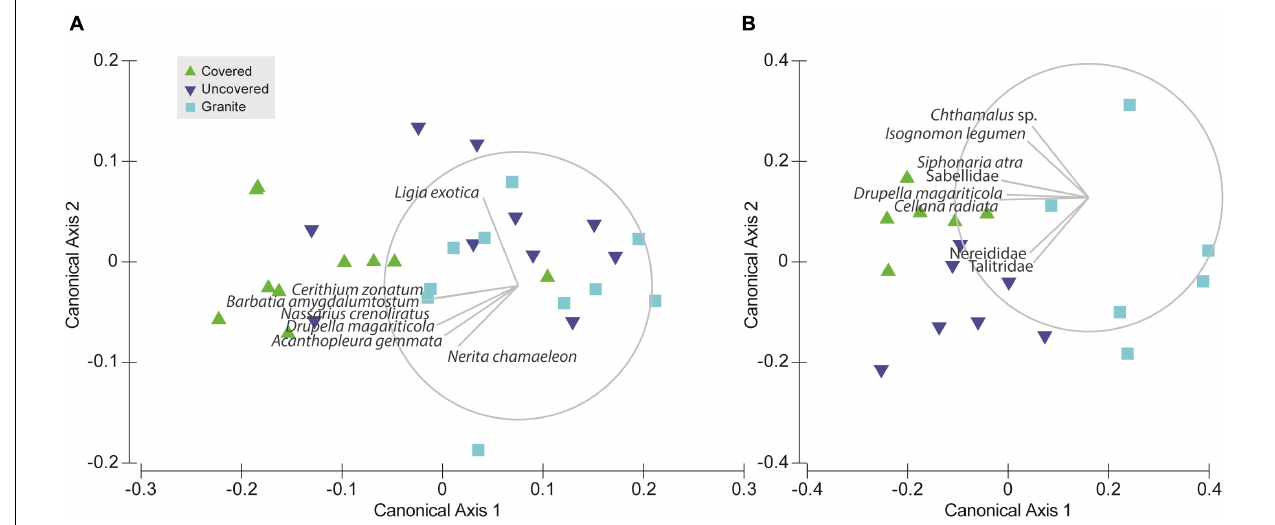
FIGURE 5 | Canonical analysis of principal coordinates (CAP) ordination for the tile treatments at each site: (A) Pulau Hantu and (B) Kusu Island; the vector overlay is applied to each plot using Pearson correlation ( ρ = 0.6) to explore species relationships with the canonical